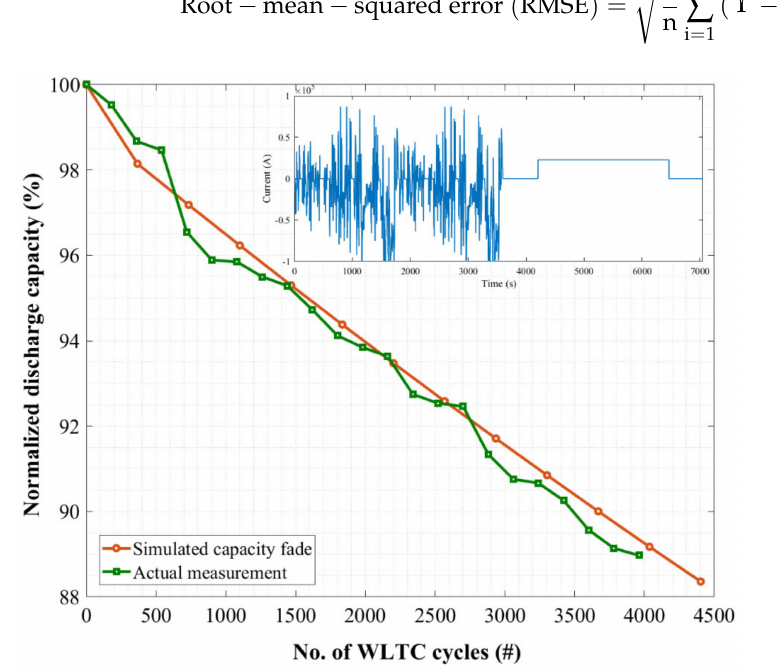
Figure 4. Lifetime simulation results at 25 ◦ C for WLTC